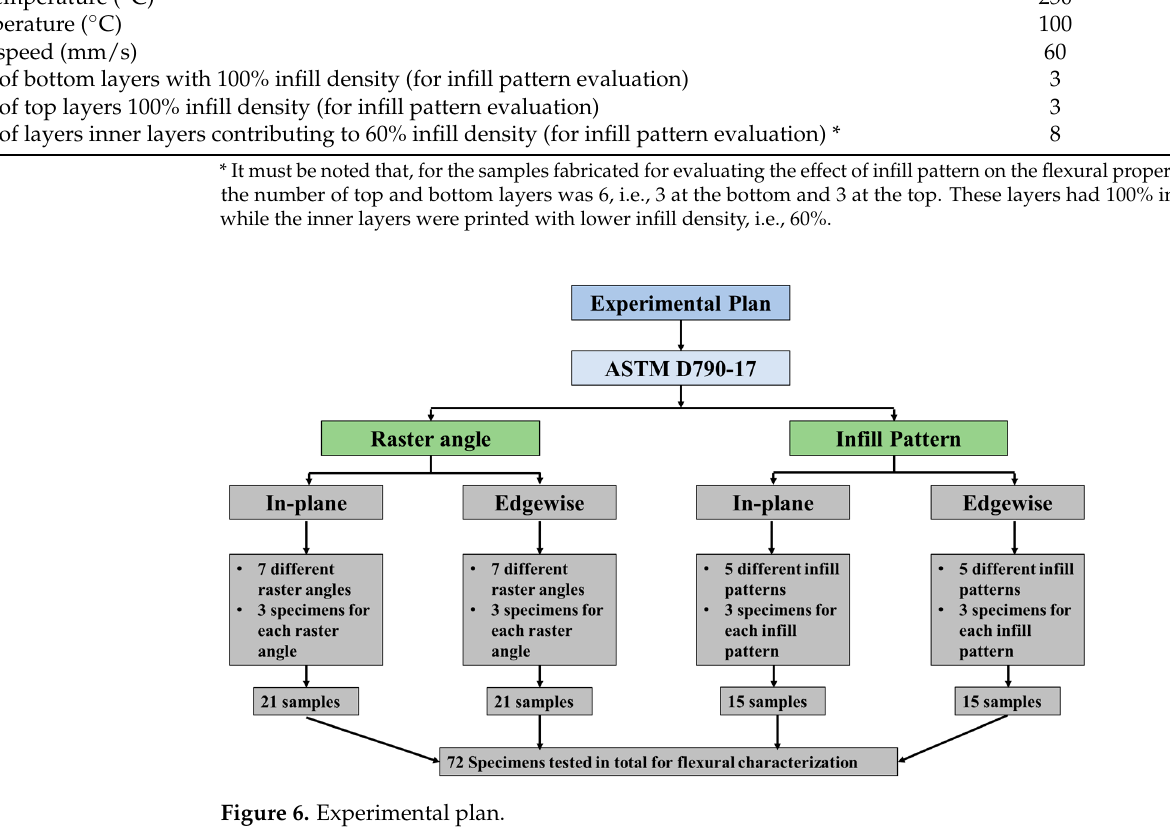
Figure 5. Infill patterns assessed in this study. Table 1. Process parameters used for 3D printing of specimens in this study.